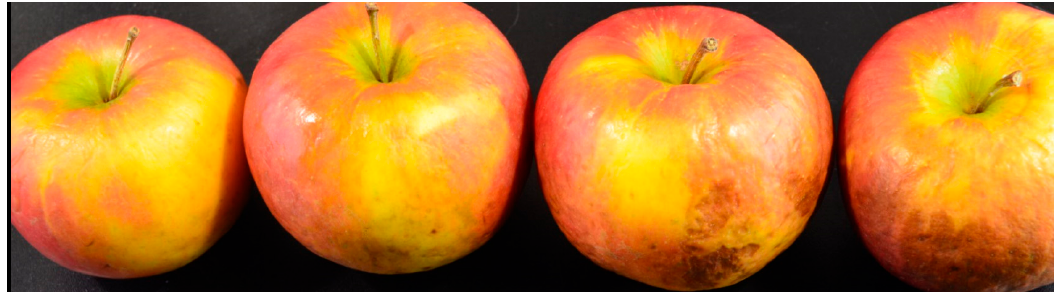
Figure 1. Superficial scald on Malus × domestica cv. Ladina. Examples of superficial scald in apple variety Malus × domestica cv. Ladina in increasing degrees from left to right occurring after a storage period of more than three months and especially during the shelf life at 20 °C.